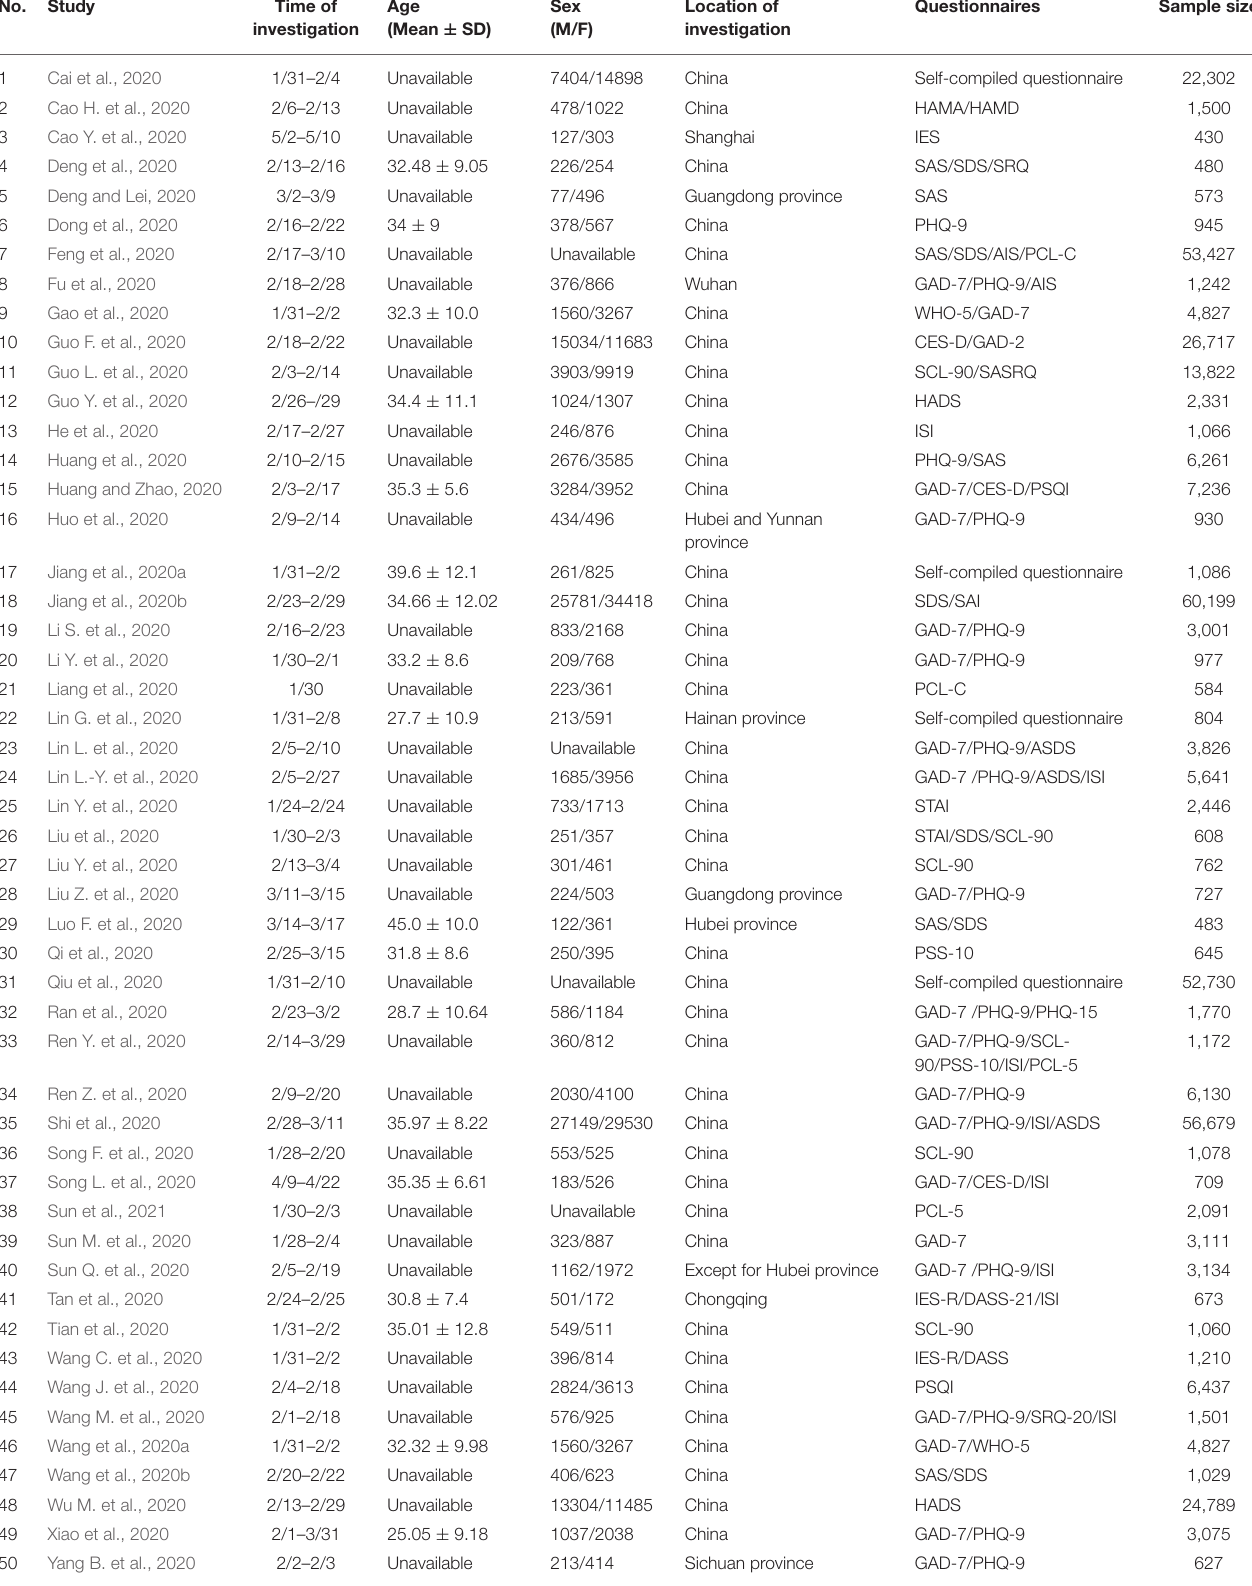
TABLE 1 | Characteristics of the included